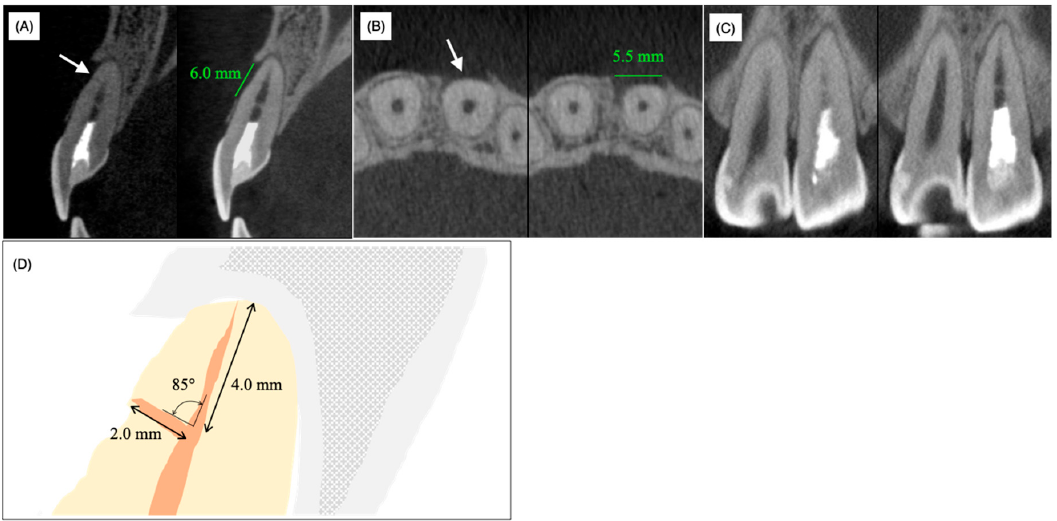
Figure 3. Preoperative cone-beam computed tomography images ( A ) sagittal, ( B ) horizontal and ( C ) coronal. The arrow in ( A ) indicates the lateral foramen. ( D ) Schematic view of the sagittal section of the upper left incisor.